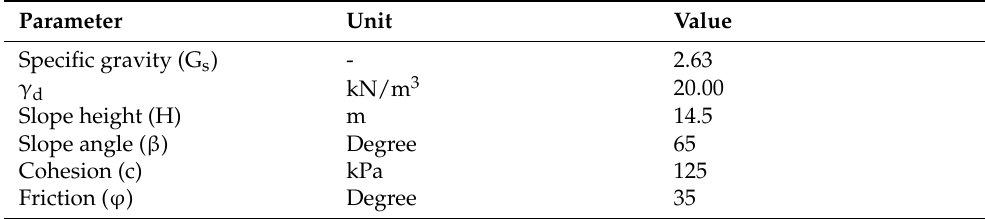
Table 6. The geotechnical information used for the example stability analysis.